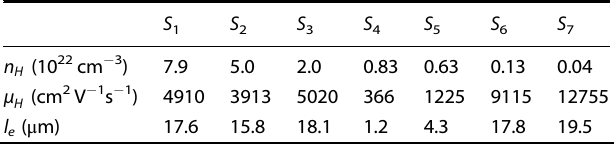
Fig. 3 The Carrier properties of SCMO thin fi lms S 1 – S 5 . a carrier density, and b Hall Table 1. The carrier characterization of samples S 1 – S 7 at 2 K.